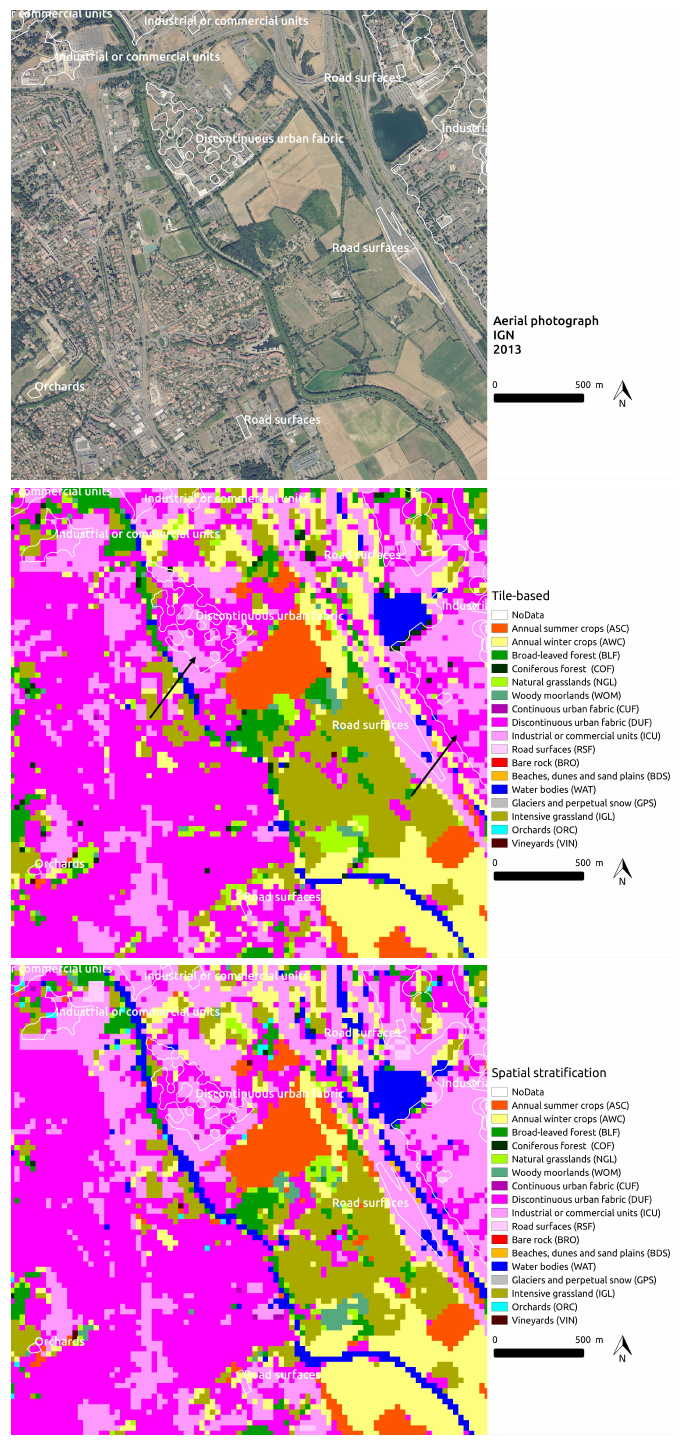
Figure 20. Analysis of errors on an urban area. Errors are marked with black